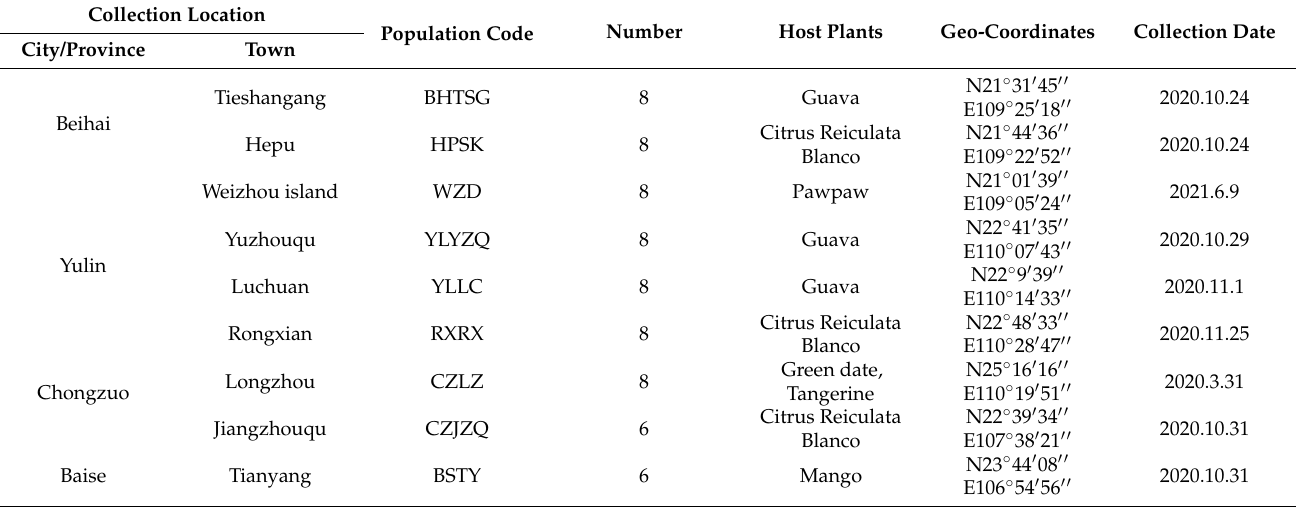
Table 1. The Bactrocera dorsalis populations used in this